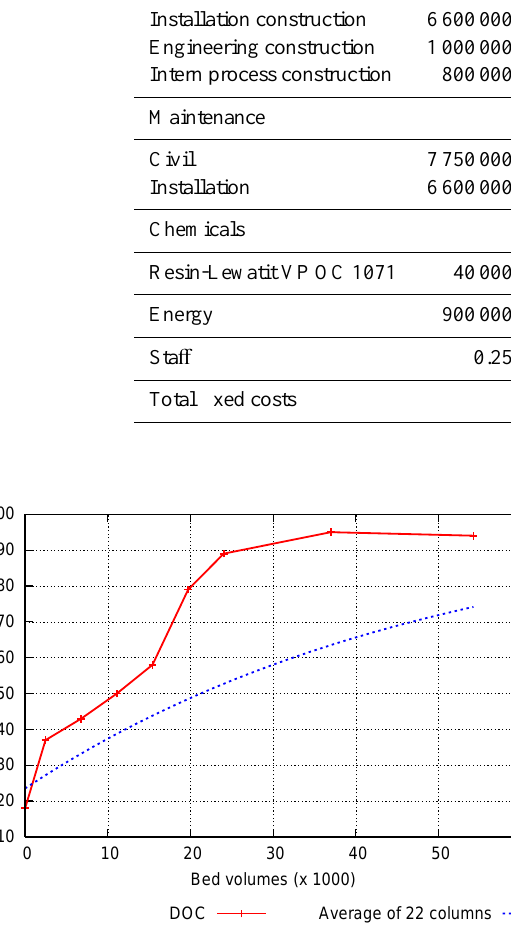
Table 3: Total fixed costs